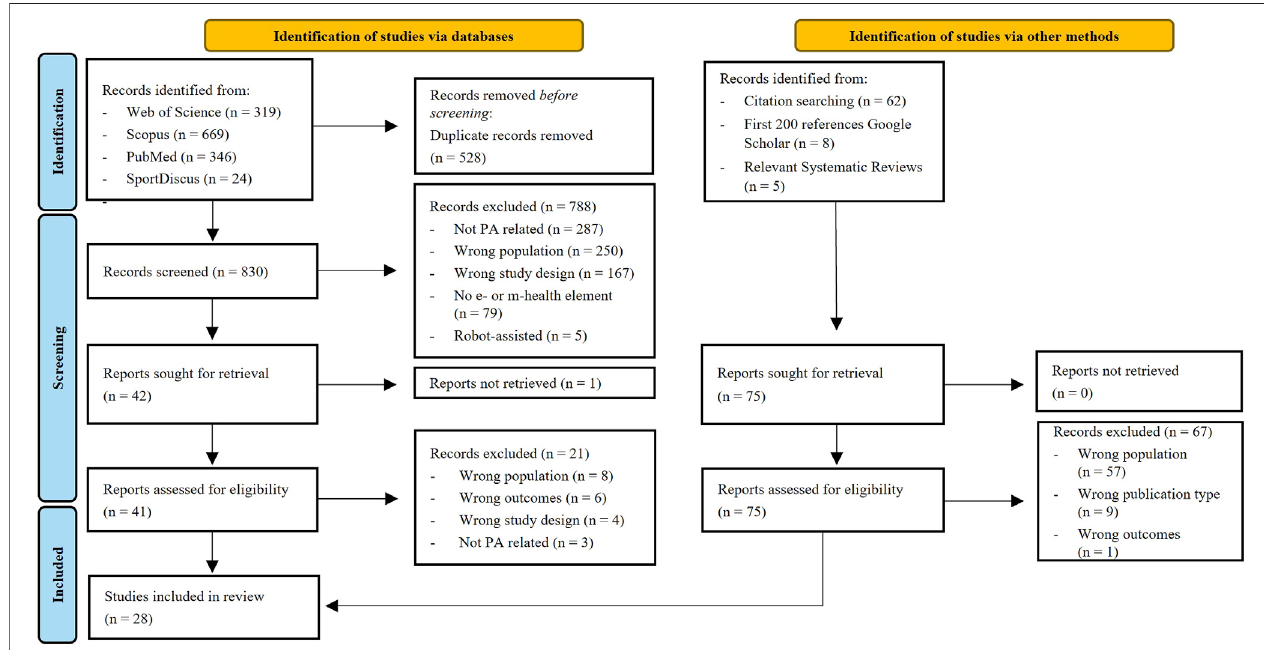
FIGURE 1 | PRISMA fl ow diagram of the study selection